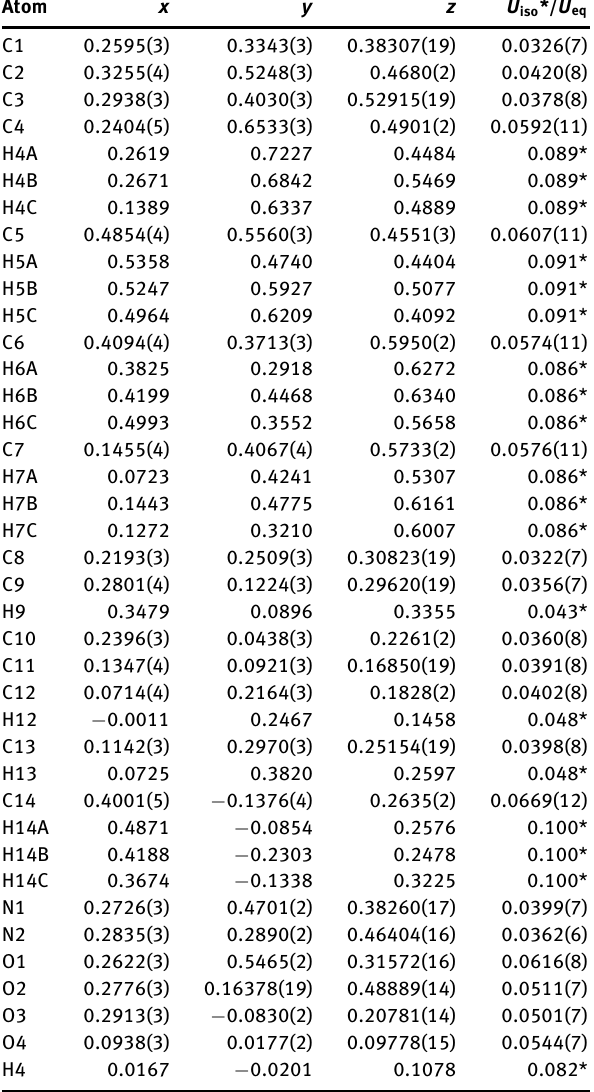
Table 2: Fractional atomic coordinates and isotropic or equivalent isotropic displacement parameters (Å 2 ).